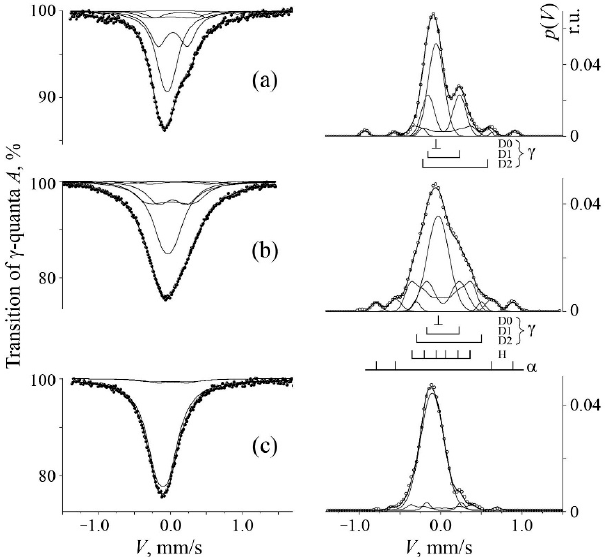
Figure 1. Mössbauer spectra and the distribution p ( V ) for MA samples of Series B . Treatment, composition: ( a ) ball milling (BM), composition 2 (Fe–14.2Cr + 20% Mn 2 N); ( b ) BM, composition 1 (Fe + 20% Mn 2 N); ( c ) BM, annealing at 800 ◦ C, 1 h, composition 1 (Fe + 20% Mn 2 N). In the distribu- Table 3. Hyper-fine parameters of simulated spectra of the MA nitrogen-containing austenite, stainless austenite Fe– 22Mn–18Cr–0.8N steel, and nitrogen-containing γ iron.